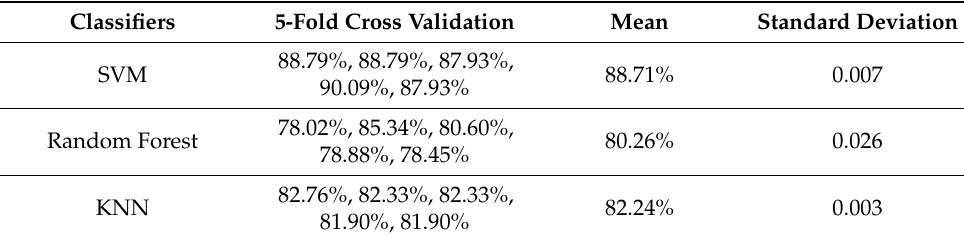
Table 2. The recognition performance of six activities.